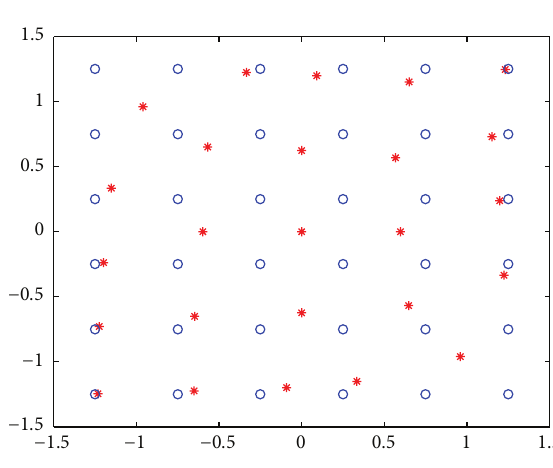
Figure 7: The elements’